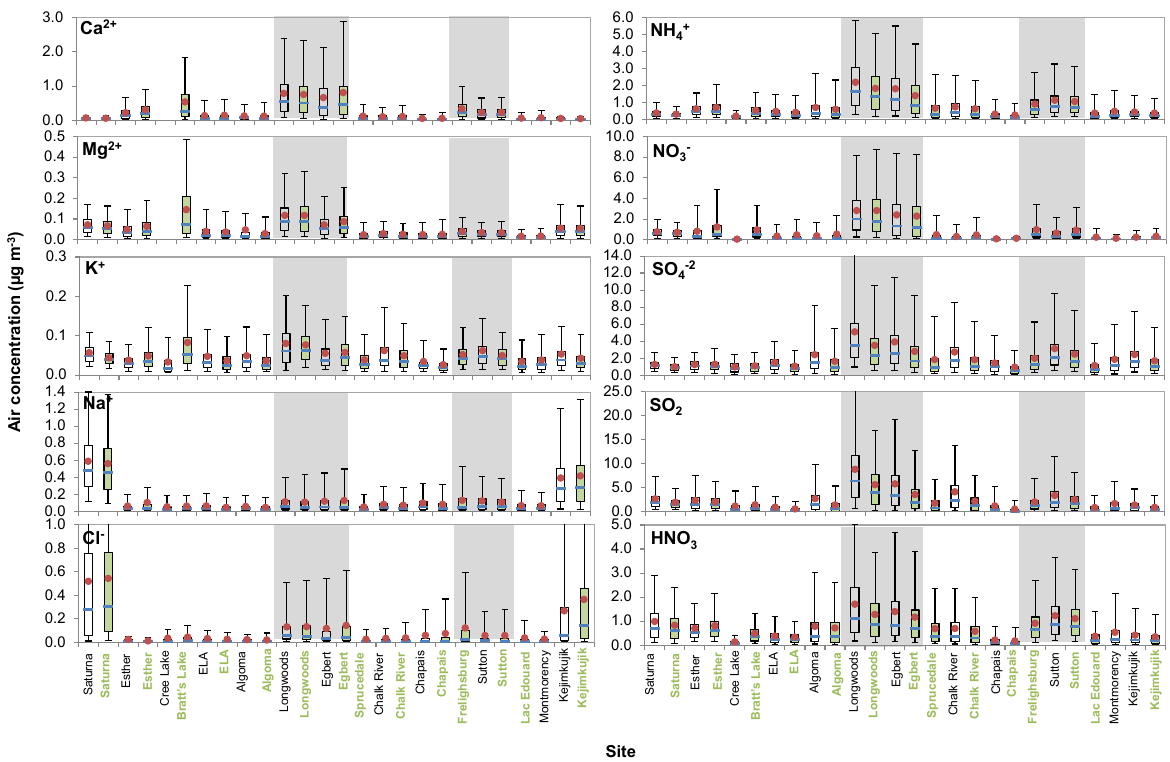
Figure 1. Geographical patterns of particulate inorganic ions and trace gas concentrations. Sites are arranged in order from western to eastern Canada. Grey shaded regions correspond to southern Ontario or southern Québec sites. The blue line indicates the median; the red dot indicates the mean; and the box and whiskers include the interquartile range and the 5th to 95th percentile range, respectively. White boxes indicate 1983–1996 data and green boxes indicate 1997–2010 data (site labels also shown in green for this period).